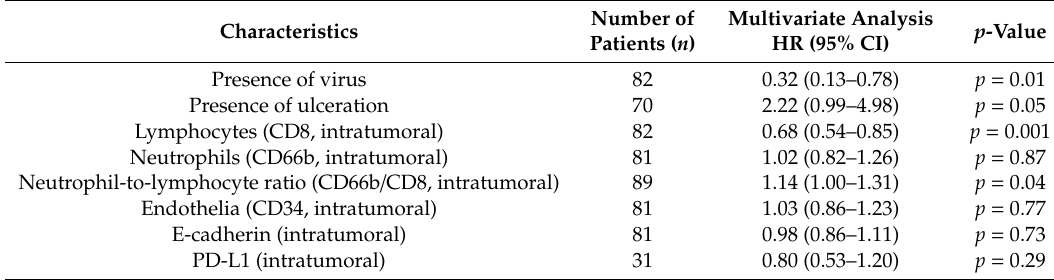
Table 3. Multivariate analysis showing MCC-specific survival based on immune cells and biomarkers in the tumor